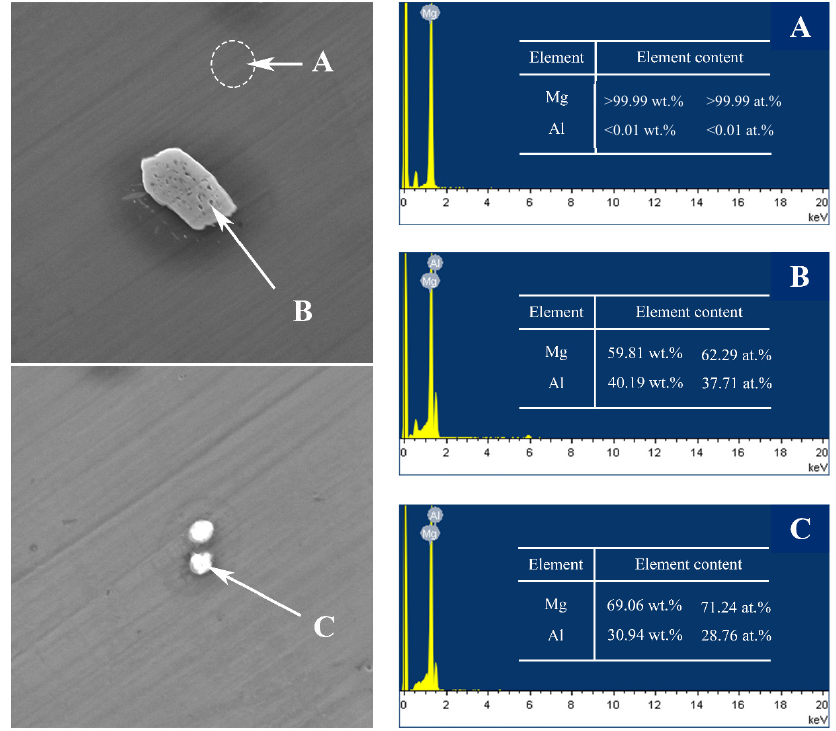
Figure 2. SEM micrographs and corresponding EDS results of as-cast Mg–4Al alloy at different position ( A – C ).